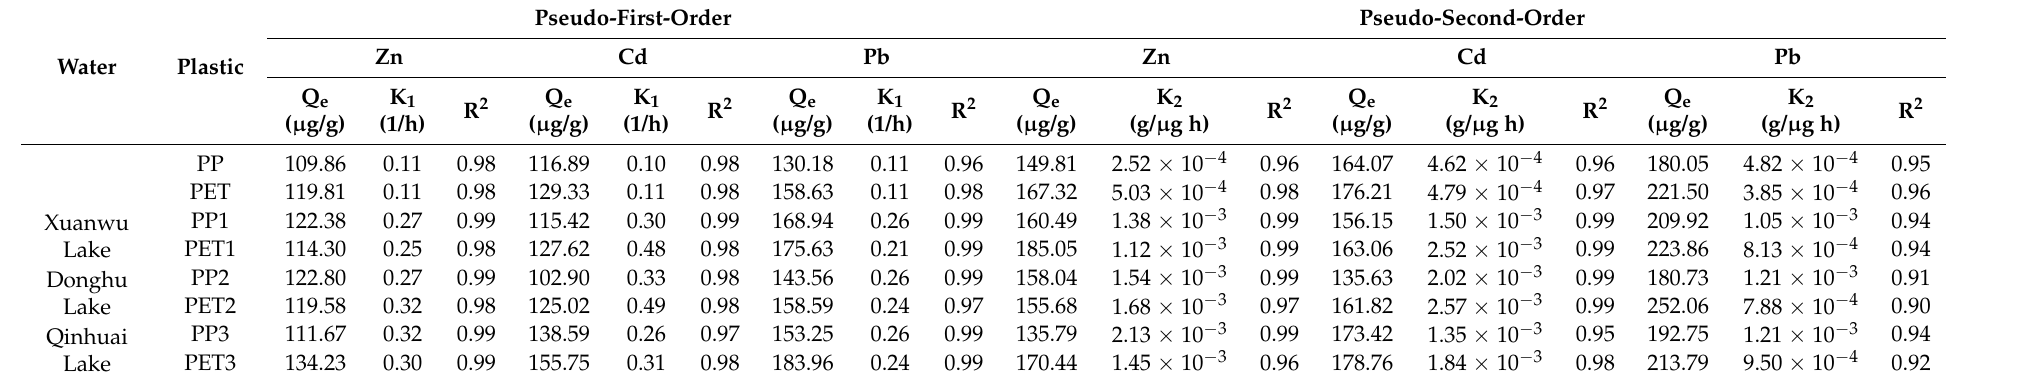
Table 2. Parameters of pseudo-first-order model and pseudo-second-order model used in the